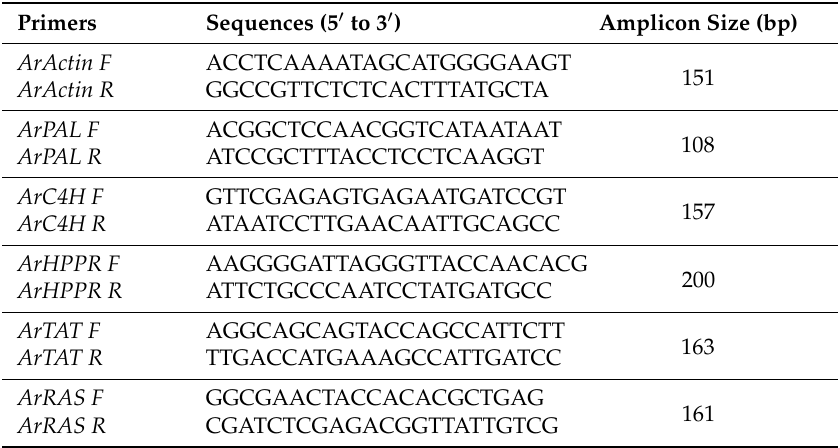
Table 1. Primers used to qRT-PCR